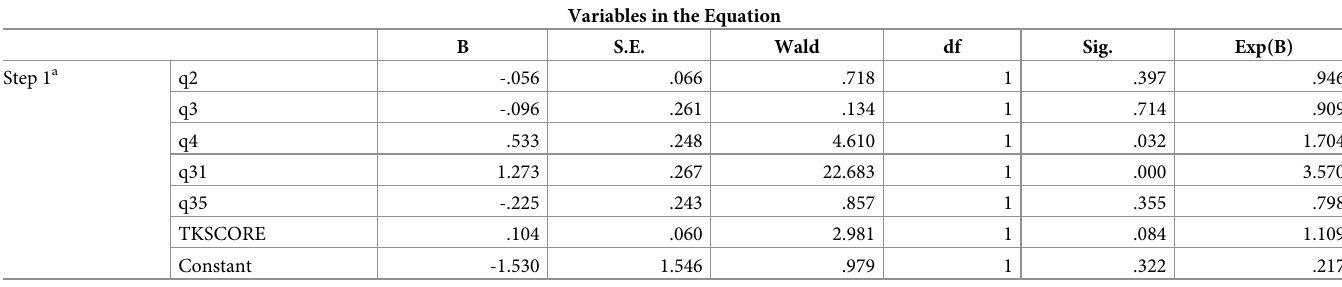
Table 4. Results of logistic regression predicting vaccination against